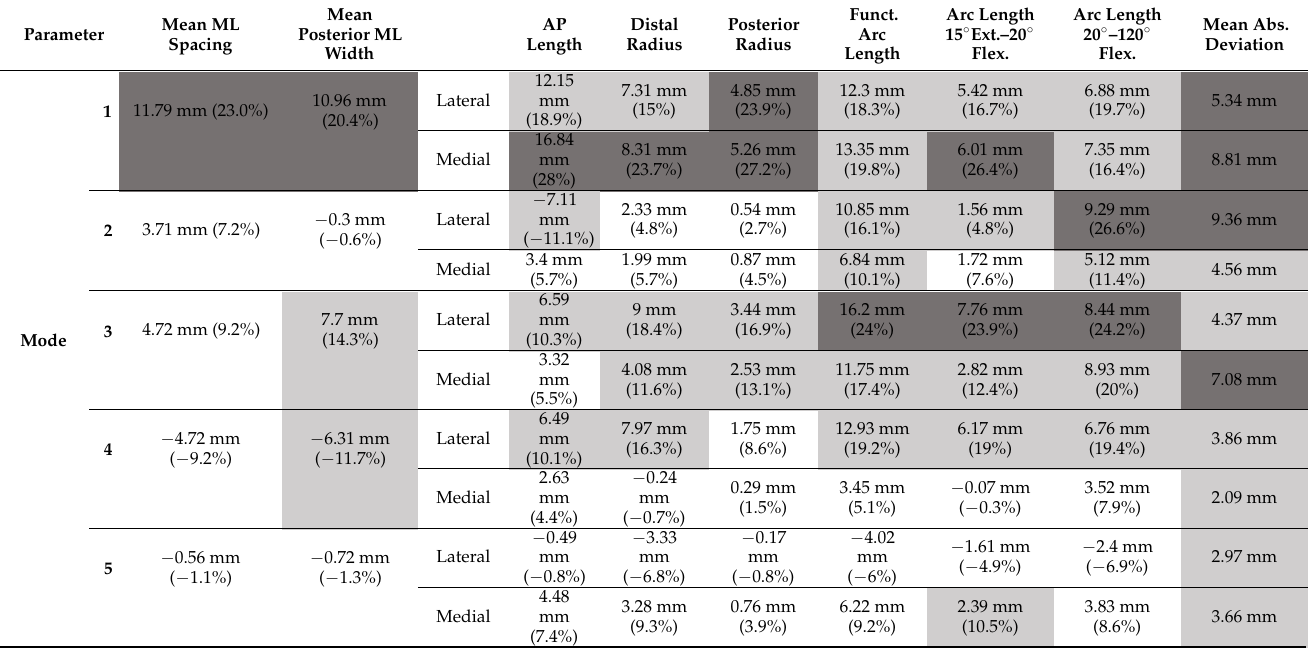
Table 3. Results of the geometric parameter analysis: Effect sizes for the first five modes are listed (+3SD). Deviations with regard to the mean shape are quantified in millimeter and in percent. Changes exceeding predefined limits are highlighted (color code below). Abbreviations: AP = anteroposterior, ML = mediolateral. Parameter Mean Abs.